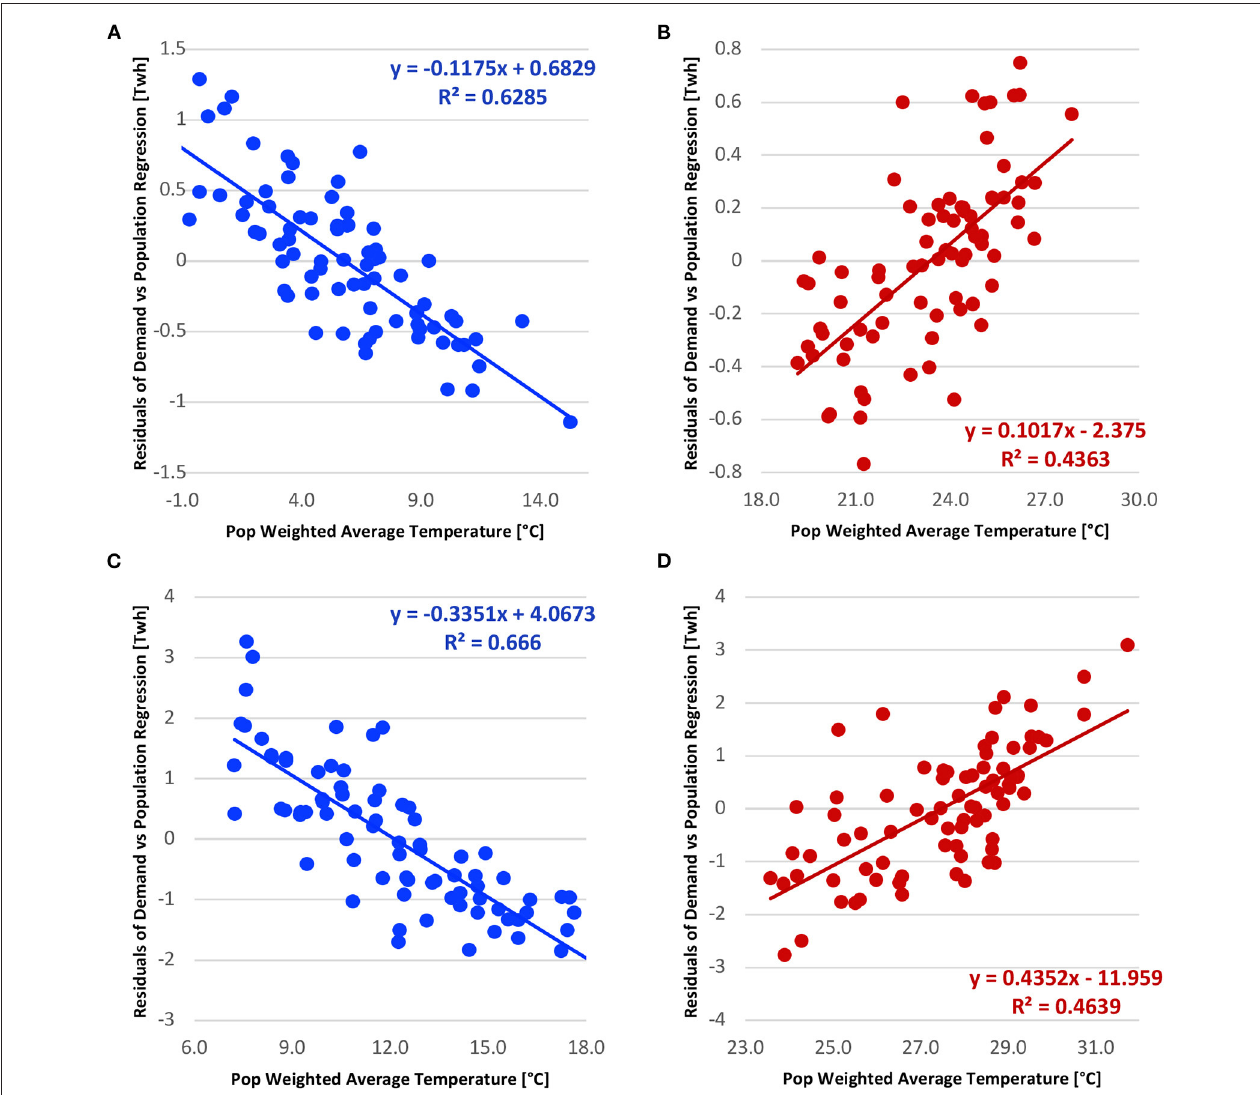
FIGURE 3 | Scatter plots of residuals from the regression between electricity demand and population with observed monthly population weighted average temperature for (A) TN winter, (B) TN summer, (C) TX winter, and (D) TX summer. Residuals corresponding to winter (summer) months are indicated in blue (red)